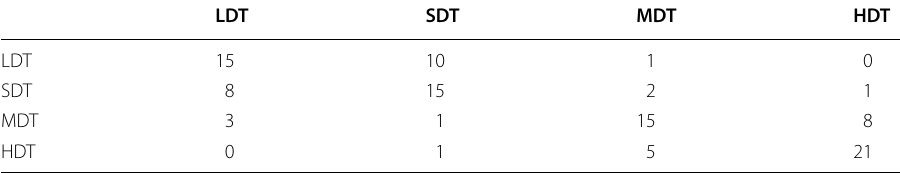
Table 12 Confusion matrix for the Naïve Bayes Predictor